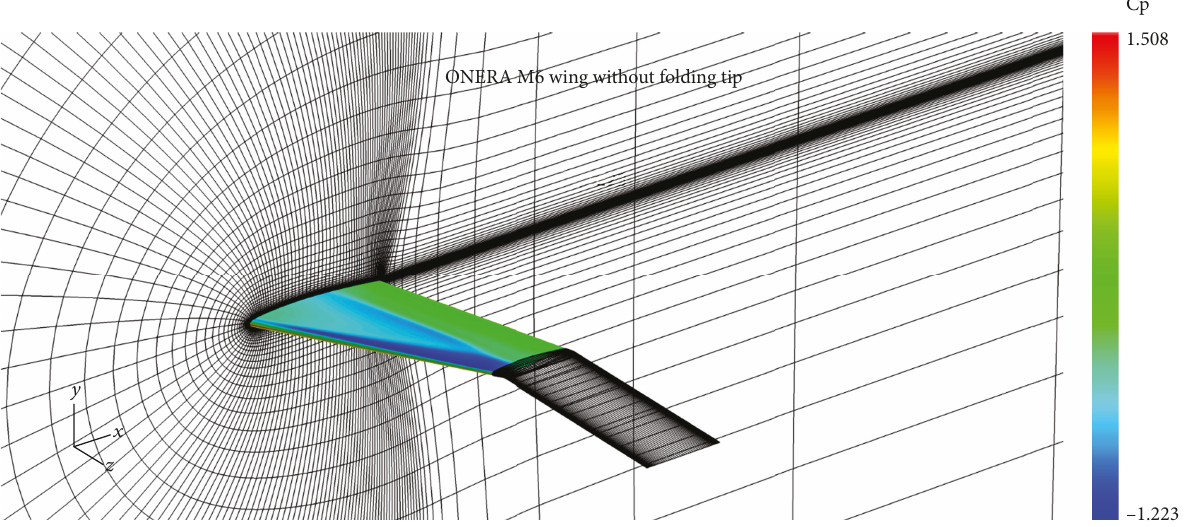
Figure 17: ONERA M6 wing shown in the computational mesh ( 163 × 39 × 65 ).